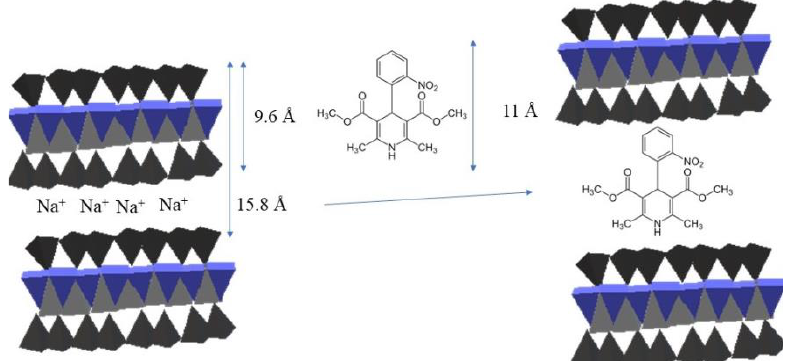
Figure 2. Representative scheme of nifedipine intercalation in the interlayer spacing of montmoril- lonite. Adapted with permission from ref. [67]. 2022, Elsevier.